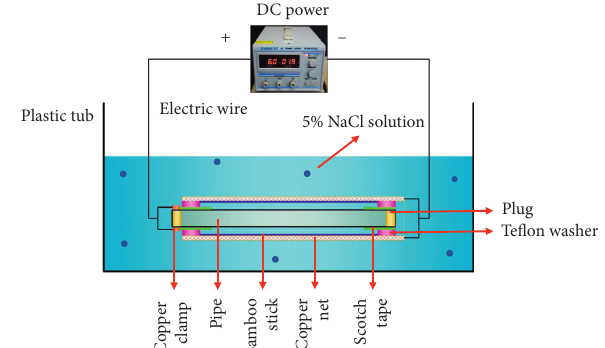
Figure 4: Schematic diagram of electrochemical corroding